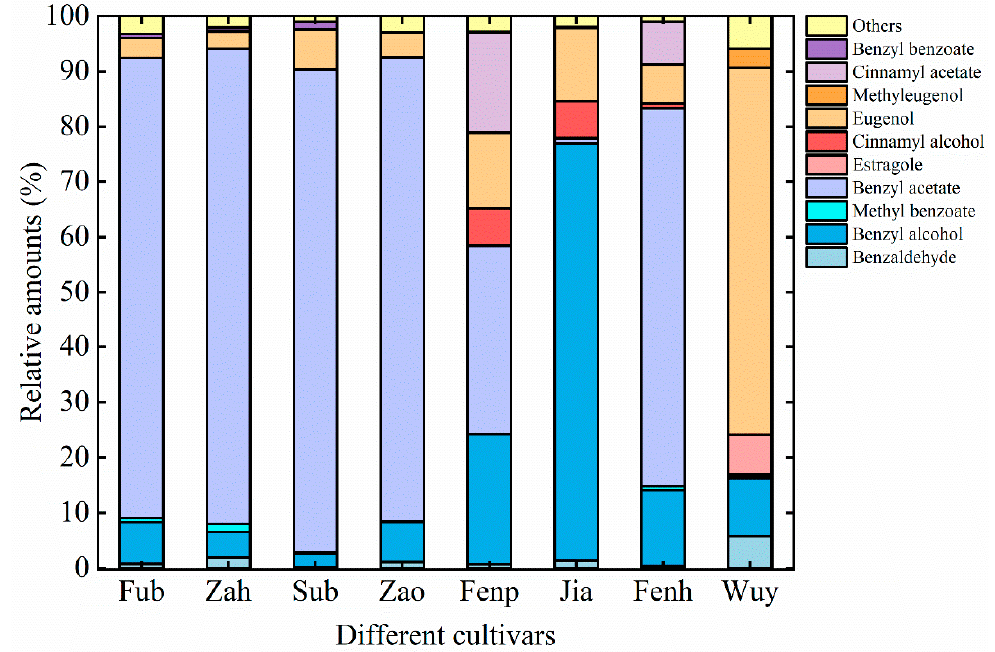
Figure 2. Major components ( > 1%) of floral volatiles emitted from P. mume cultivars.